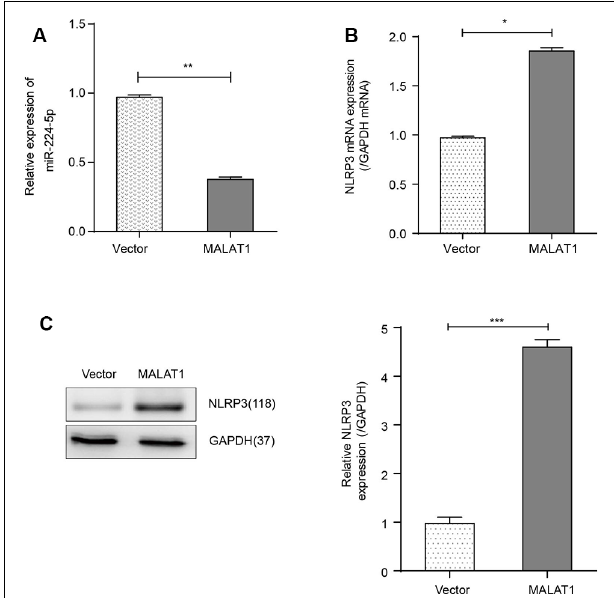
FIGURE 4 | Overexpression of MALAT1 promoted the inflammatory response of BV2 cells. (A) The results of qRT-PCR showed that the expression of miR-224-5p in MALAT1-transfected BV2 cells decreased significantly compared with that in control (vector) BV2 cells. (B) qRT-PCR results showed that the mRNA expression of NLRP3 was higher in MALAT1-overexpressing BV2 cells compared with control (vector) BV2 cells. (C) The results of western blot analysis showed that the expression of NLRP3 was upregulated in MALAT1-overexpressing BV2 cells compared with control (vector) BV2 cells. * p < 0.05, ** p < 0.01, *** p < 0.001 vs. the vector